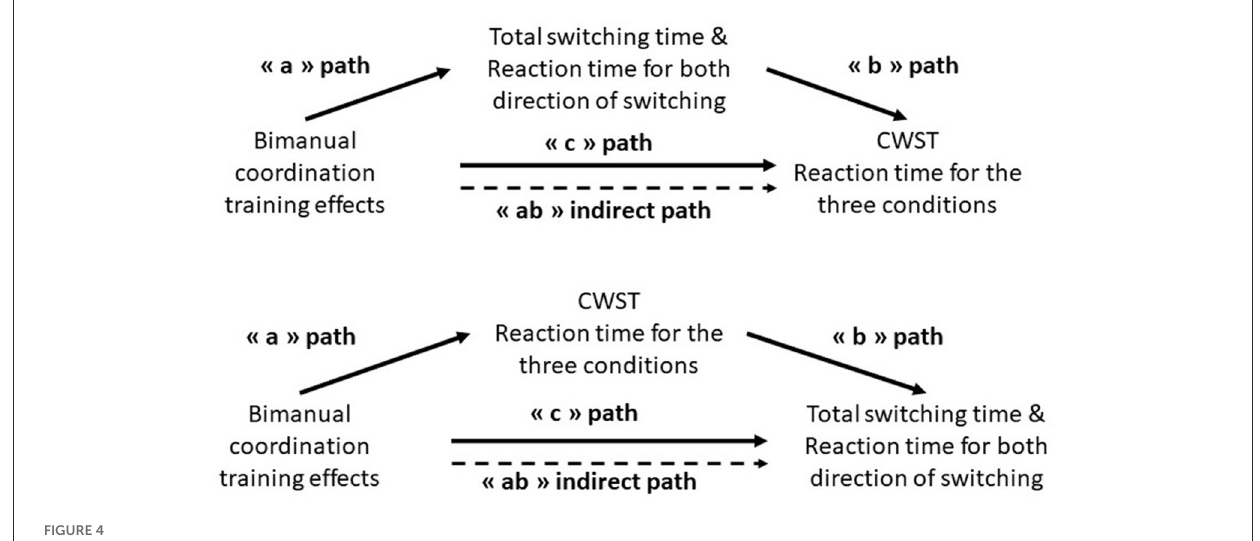
FIGURE4 Illustration of the two mediation